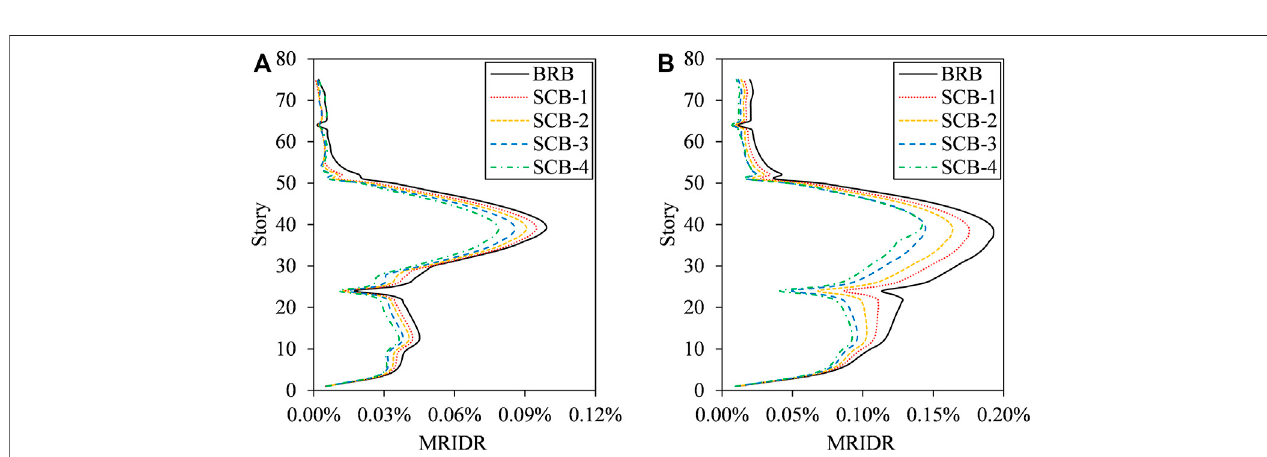
FIGURE 14 | Comparison of distribution of MRIDR of study cases. (A) PGA = 400 cm/s 2 . (B) PGA = 510 cm/s 2 .